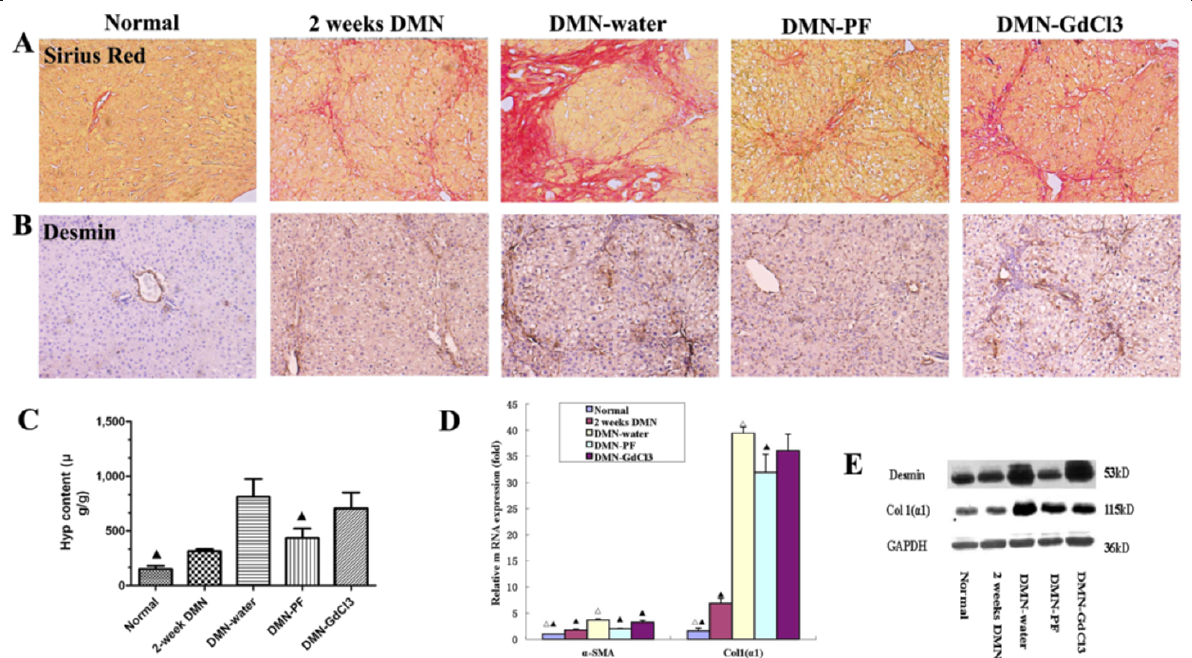
Figure 2 Effects of PF on histological changes. A , Sirius Red staining, ×100 magnification; B , desmin staining, brown staining indicates immunopositivity ×200 magnification, n=3; C , Hyp content; The number in Hyp and sirius red detection was the same as the number of animals in each group, data as mean ±SD, ☆ p <0.05 versus 2-week DMN rats; ⋆ p <0.05 versus DMN-water rats. Kruskal-Wallis test was used for group comparisons in Hyp. D , α -SMA and Col1( α 1) using real-time PCR analysis, as an internal control, 18S rRNA was amplified (n=3), data as mean ±SD, ▴ p <0.05 versus DMN-water rats; Δ p <0.05 versus 2-week DMN rats. Bonferroni ’ s multiple comparison test were used for group comparisons in α -SMA and Col1( α 1). E , the expression of desmin and Col1( α 1) was analyzed using western blot in rat livers with DMN-induced liver fibrosis (n=3); western blotting of total protein extracts with antibodies recognizing desmin, Col1( α 1), and GAPDH